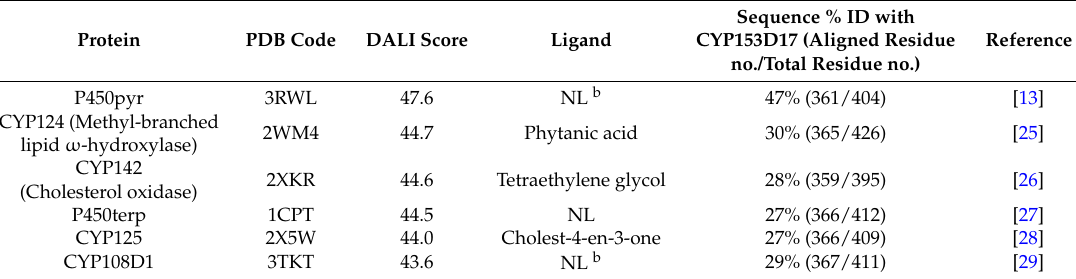
Table 3. Selected structural homologues of CYP153D17 from a DALI search (DALI-Lite server a ). Protein PDB Code DALI Score Ligand